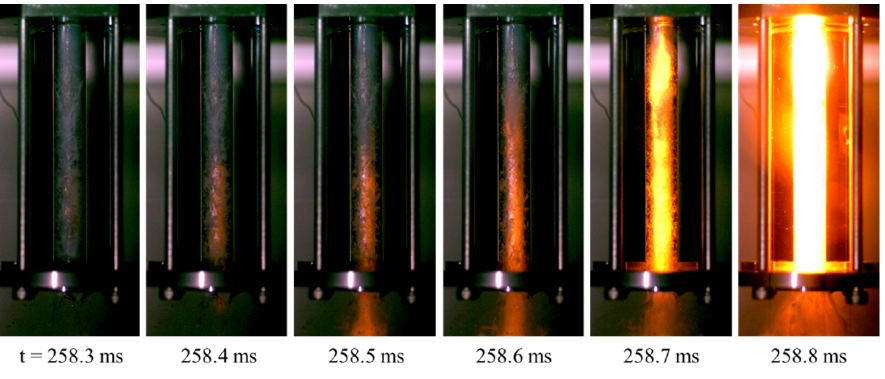
Figure 16. Detailed time history of hard start.